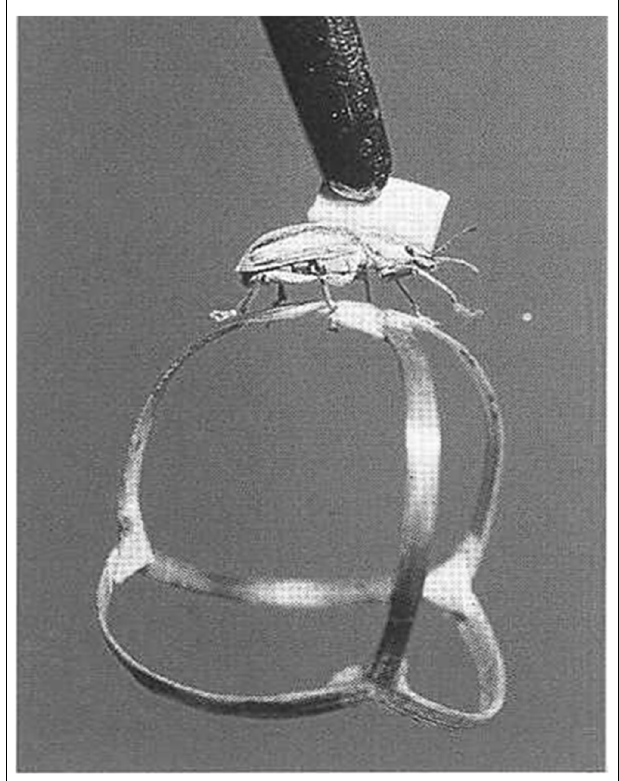
FIGURE 2 |Tethered Chlorophanus walking on aY-maze